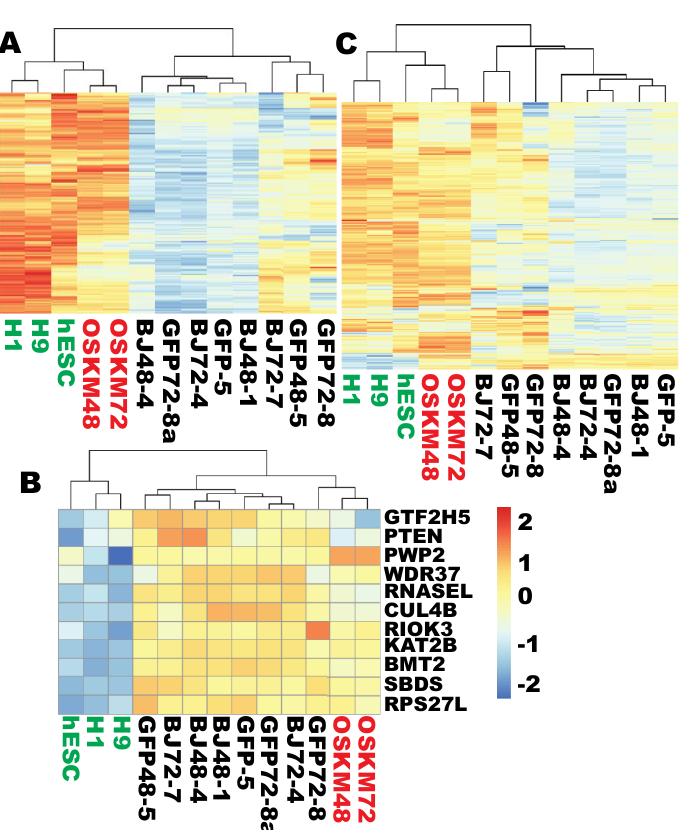
Figure 2. Proper reprogramming of ribosome biogenesis at the early stage of Yamanaka reprogramming. ( A ) A heat map showing that the 170 hPSC-enriched (> 1.5×, q < 0.05) RB genes were upreprogrammed to the pluripotent state within 48 h. ( B ) A heat map showing that the 11 fibroblast-enriched RB genes were not downreprogrammed to the pluripotent state up to 72 h of OSKM induction and remained clustered with fibroblasts. ( C ) A heat map showing that the entire set of 298 RB genes became clustered with the hPSCs upon OSKM reprogramming. H1 and H9, human embryonic stem cell lines H1 and H9, respectively. The first number after the fibroblast or treatment designations is the time of RNA harvesting after seeding of cells or treatment time by OSKM or GFP, and the second number is the lane number of RNA-seq flow cells. hESCs are highlighted in green while OSKM samples are in red. hESC = 3; fibroblasts = 4; OSKM = 2. See also Supplementary Tables S6-10 and Supplementary Figures S5 and S6.